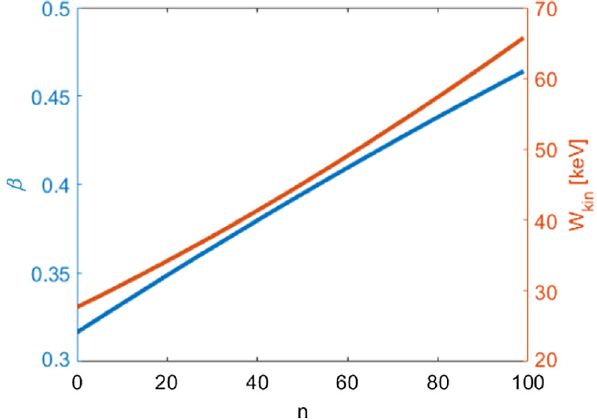
FIG. 11. Acceleration ramp according to Eqs. (56) and (58).